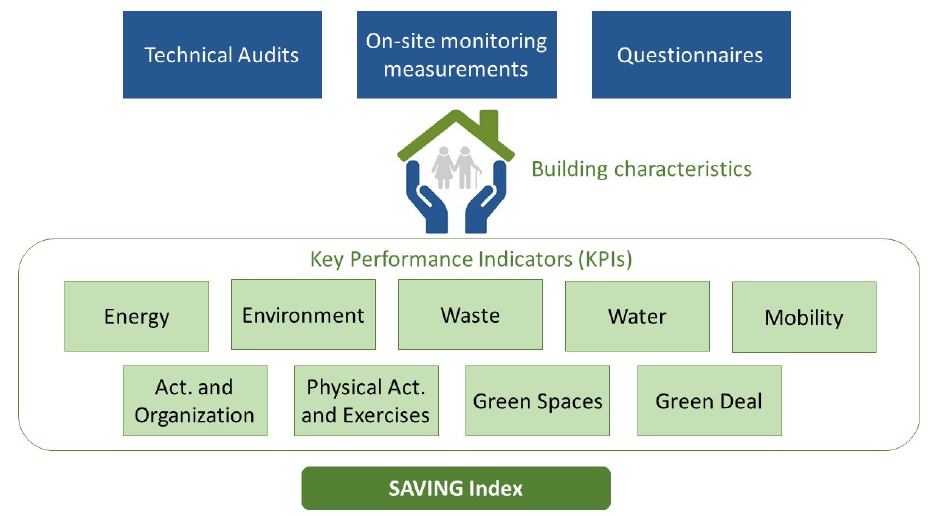
Figure 2. Overview of the multi-criteria assessment methodology .